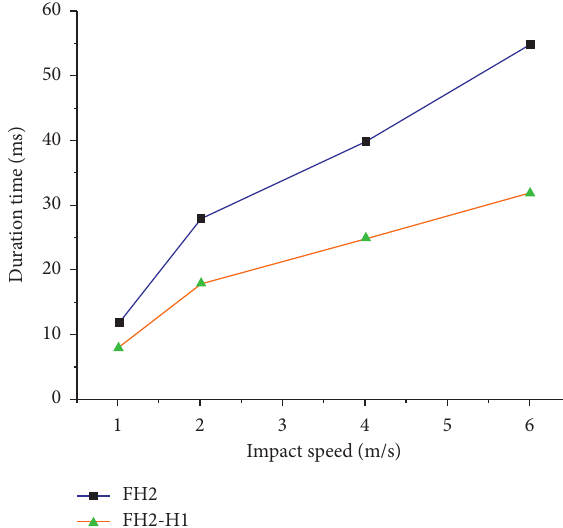
Figure 15: Speed-impact duration time